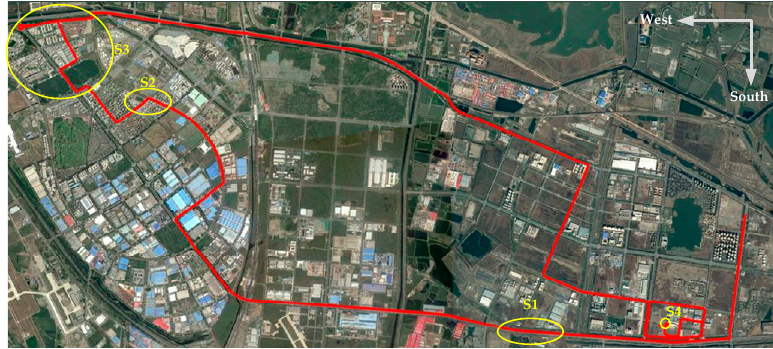
Figure 16. Four segments in the vehicle trajectory selected for detailed analyses.